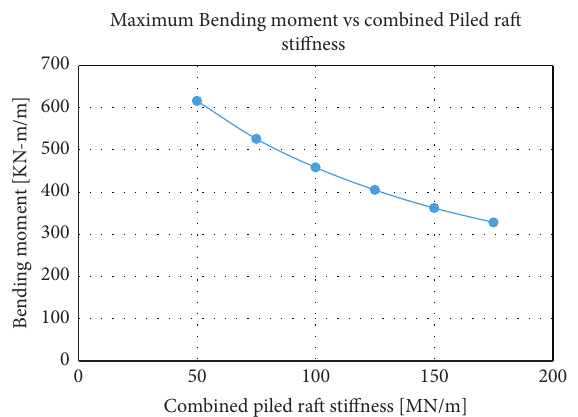
Figure 12: Variation of bending moment with stiffness.